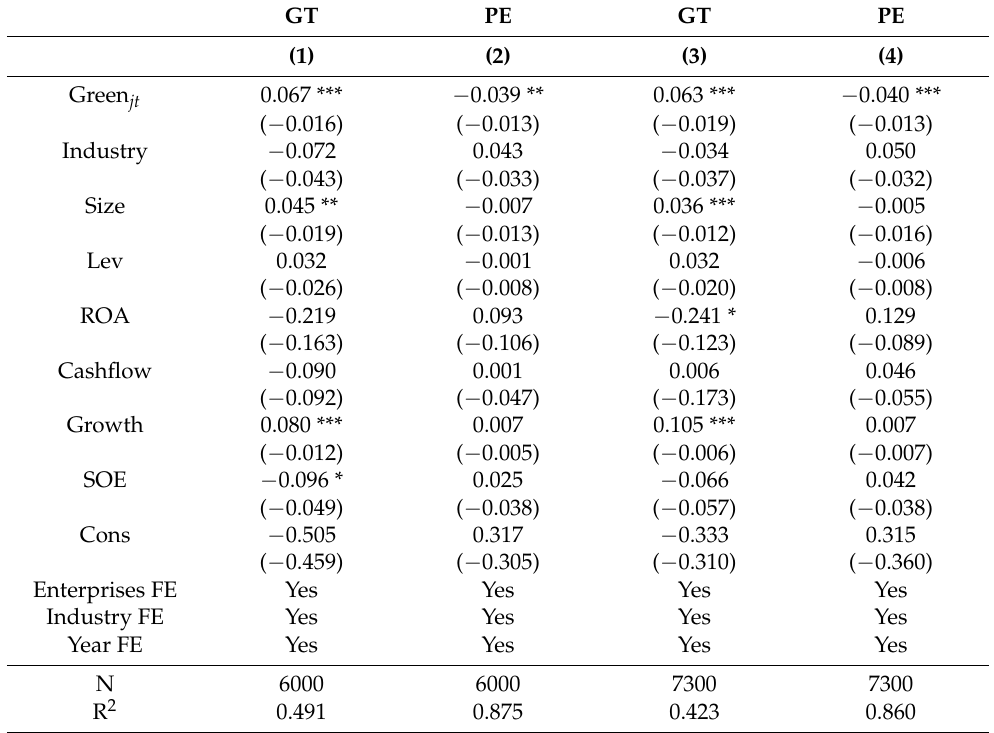
Table 4. PSM/EBM-DID estimation